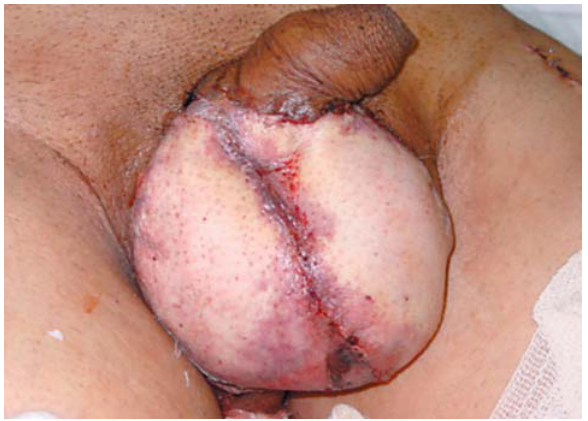
Figure 3 – Postoperative aspect of the reconstructive surgery of the scrotum with thigh skin graft.